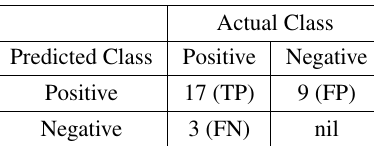
Table 2. Confusion matrix for single oil pad set, to see if the model is capable to detecting oil pad located anywhere in the